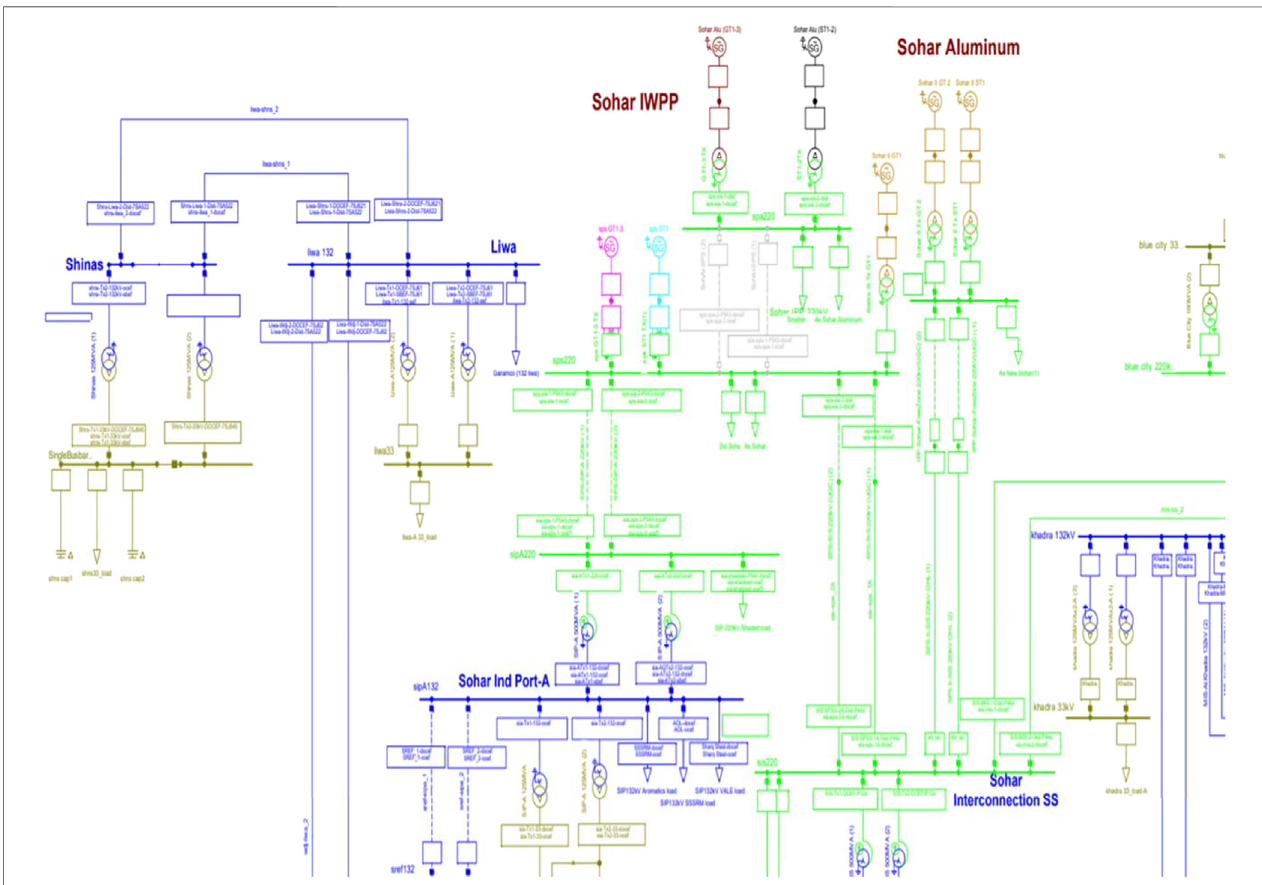
FIGURE 9 | Shinas, Liwa and Sohar transmission protection schemes.